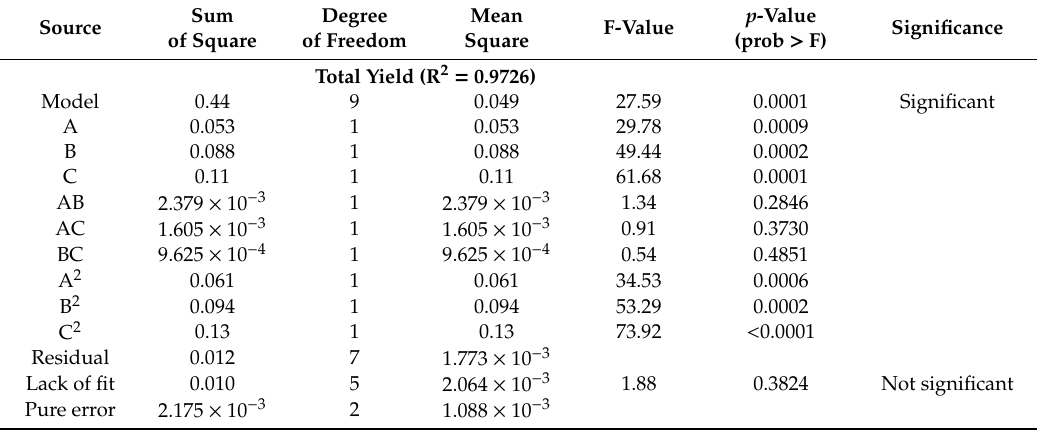
Figure 3. E ff ect of amplitude on total yield and the yield of rosmarinic acid. Data were generated from three experiments ( n = 3) and presented as the mean with standard deviation as error bars. Table 1. Analysis of variance (ANOVA) for the total yield. A: extraction time, B: amplitude, C: ethanol